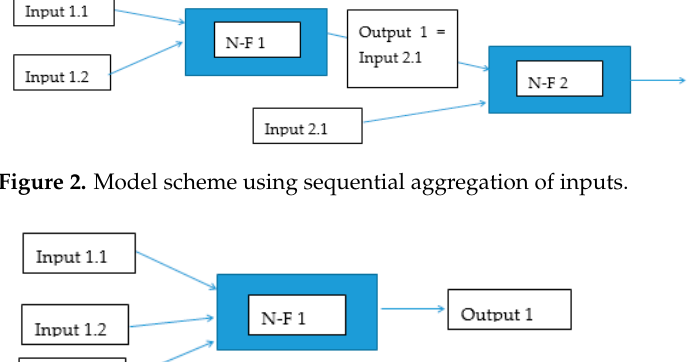
Table 1. Parameters used for model construction.